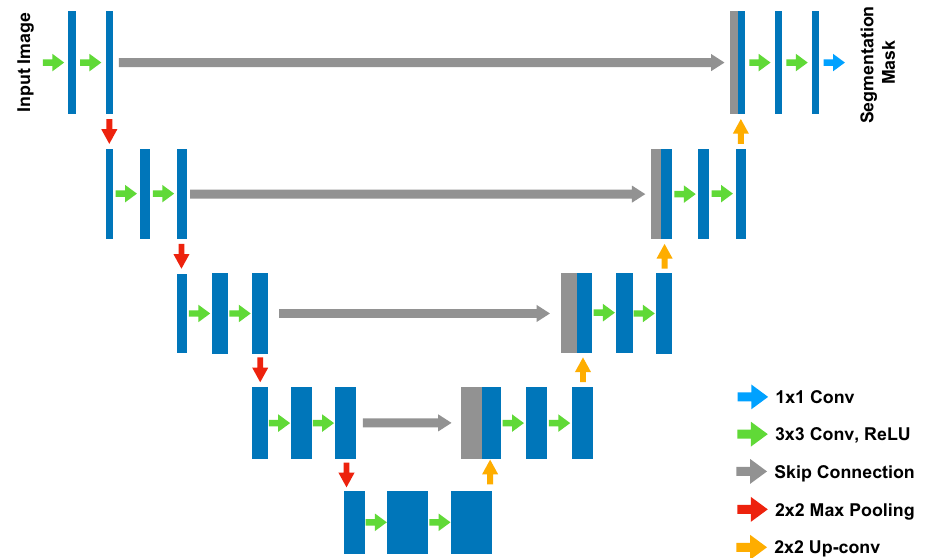
Figure 2. The architecture of U-Net. The network consists of a downsampling path and an upsampling